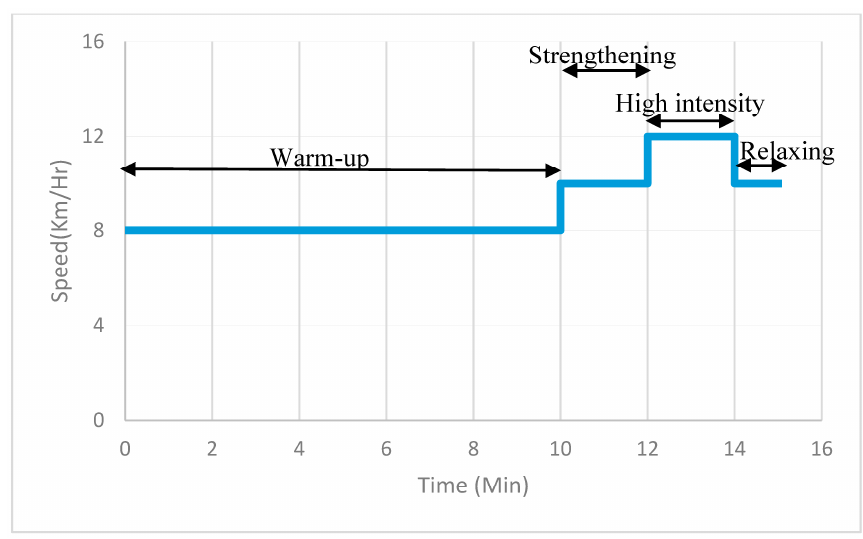
Figure 12. The speed changing diagram of treadmill.